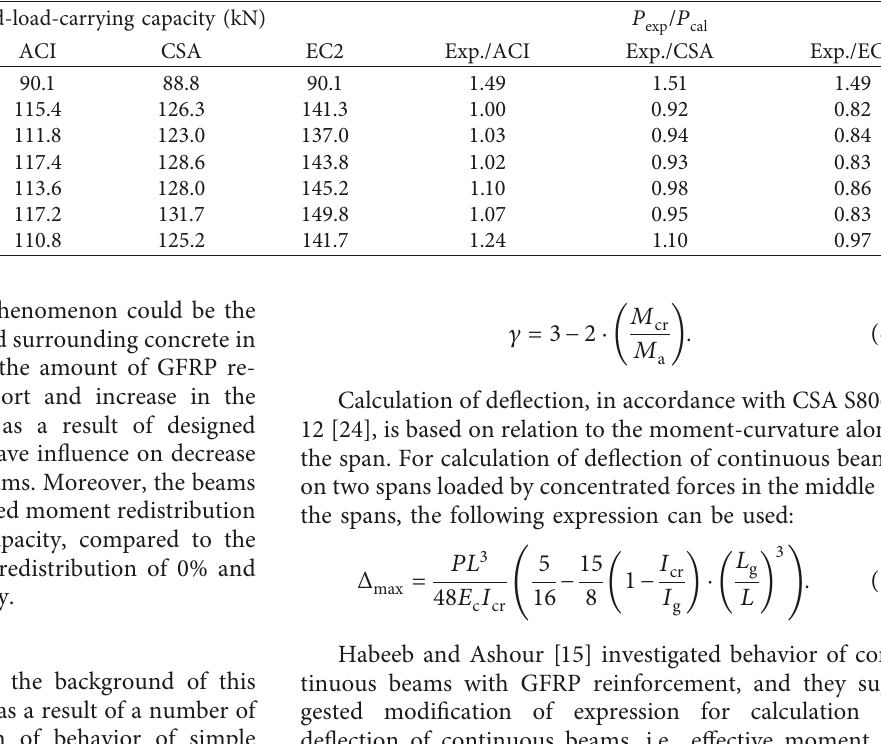
Table 5: Experimental and calculated failure loads for tested